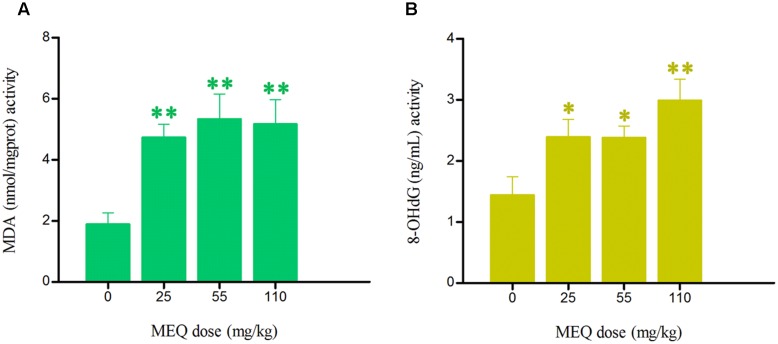
Effects of MEQ on (A) Lipid peroxidation (MDA) and (B) Peroxidation of DNA (8-OHdG) in the serum of male mice after the administration of MEQ for 18 months. ∗p < 0.05 in comparison with control, and ∗∗p < 0.01 in comparison with control. Values represent means ± SD (n = 10).